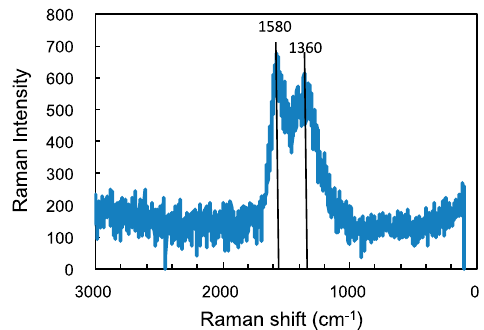
Figure 6. Raman spectrum taken on aluminum surface slid against a-C:H DLC in nitrogen with 60 ppm water.